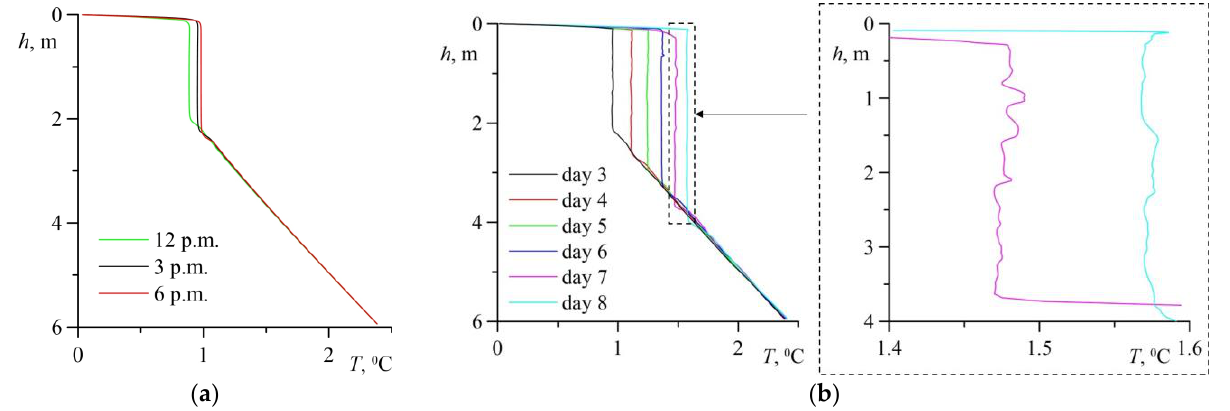
Figure 5. Depthwise temperature profiles: (a) horizontally averaged profiles at different hours of the 3rd day of calculations (Variant 1); ( b ) instant temperature profiles at 3 p.m. (Variant 1) for days 3 to 8.